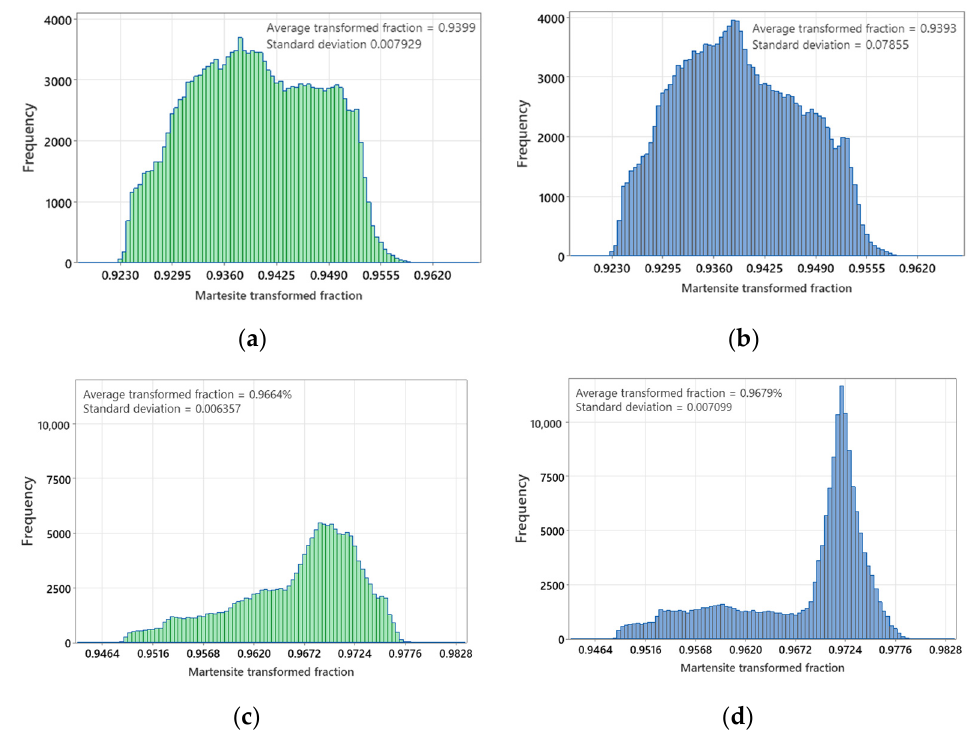
Figure 9. Nodal transformed fraction in quenched samples: ( a ) V-OQ; ( b ) H-OQ; ( c ) V-WQ; and ( d ) H-WQ.